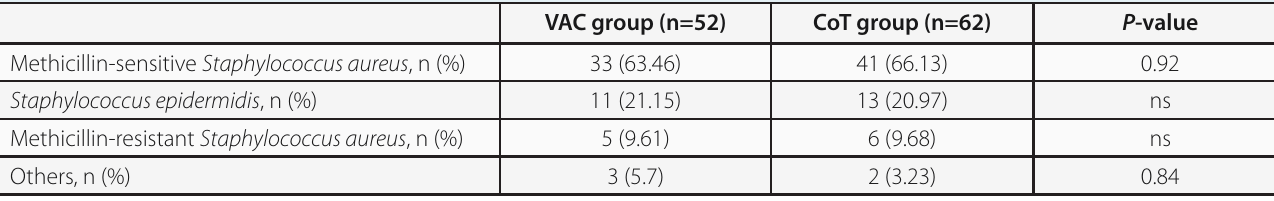
Table 4. Culture-verified post-sternotomy mediastinitis pathogens. VAC group (n=52) CoT group (n=62) P -value Methicillin-sensitive Staphylococcus aureus , n (%)